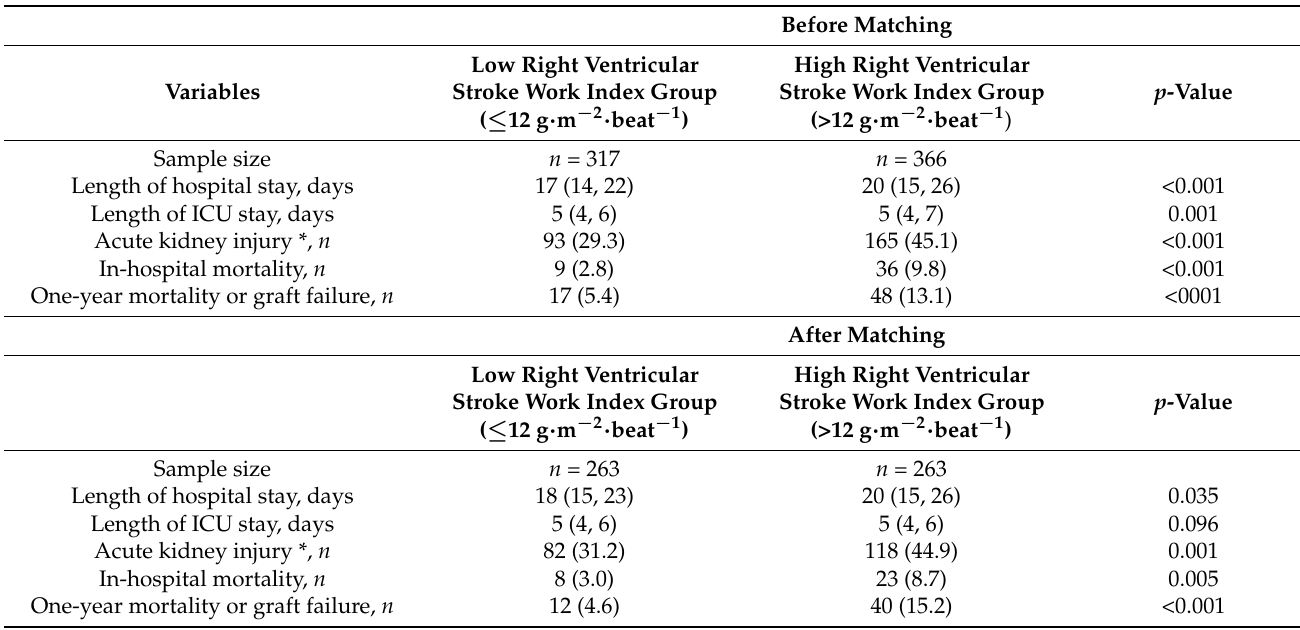
Table 3. Comparison of postoperative clinical outcomes between low and high time-weighted mean right ventricular stroke work index groups before and after propensity score